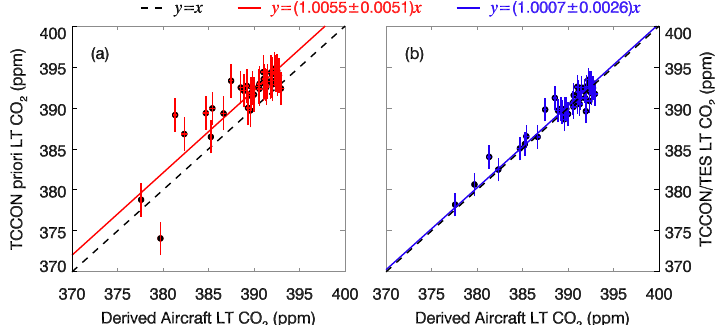
Fig. 7. (a) Comparison of LT CO 2 estimates derived from integrating from surface to 600hPa by TCCON prior and aircraft. (b) Comparison of LT CO 2 estimates derived from TCCON and TES with aircraft.